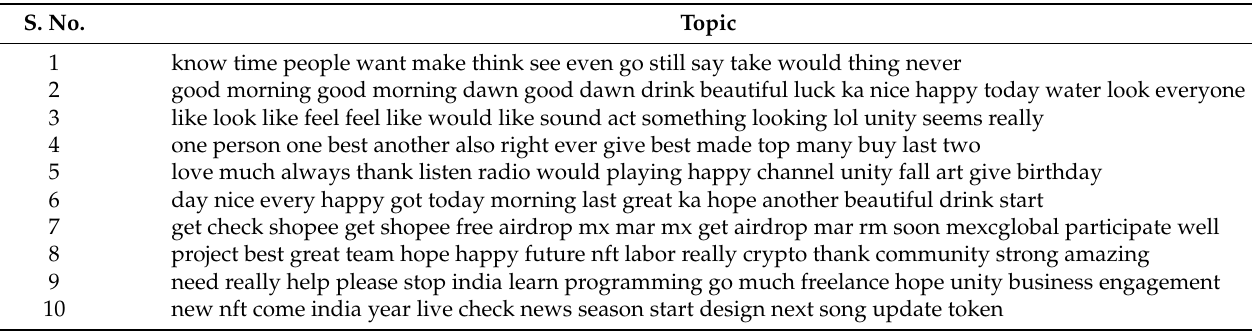
Table 4. Top 10 topics having 15 most similar words.